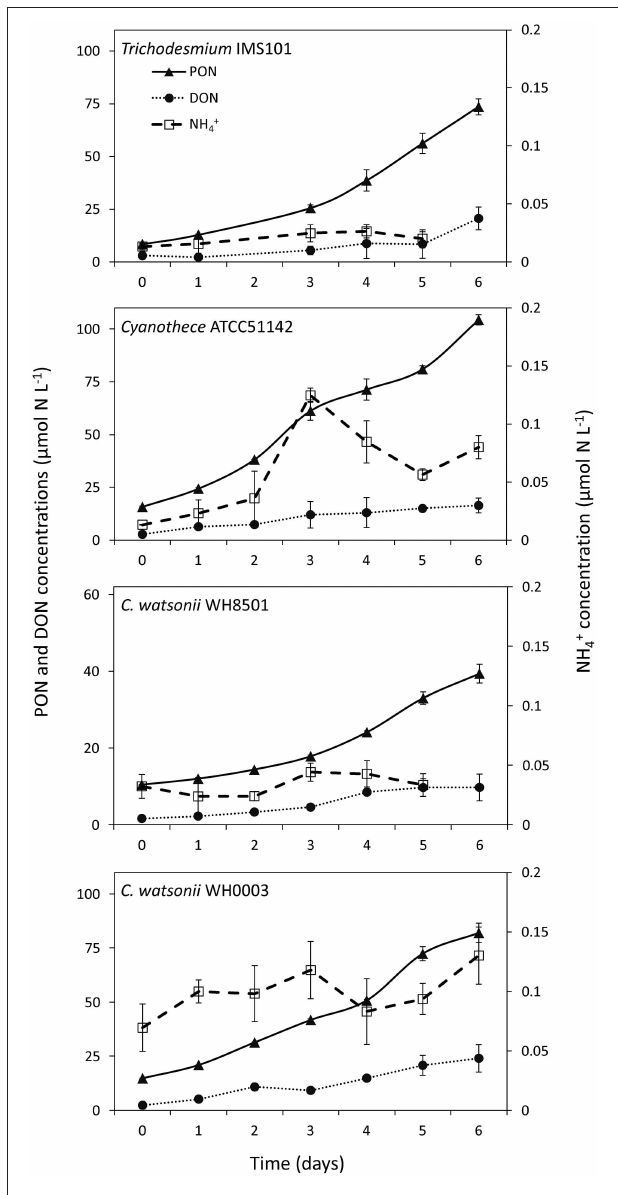
FIGURE 2 | Evolution of Particulate Organic Nitrogen (PON), Dissolved Organic Nitrogen (DON) and ammonium (NH + 4 ) concentrations during exp 1. Error bars represent the standard deviation of triplicate measurements and the propagated analytical error.